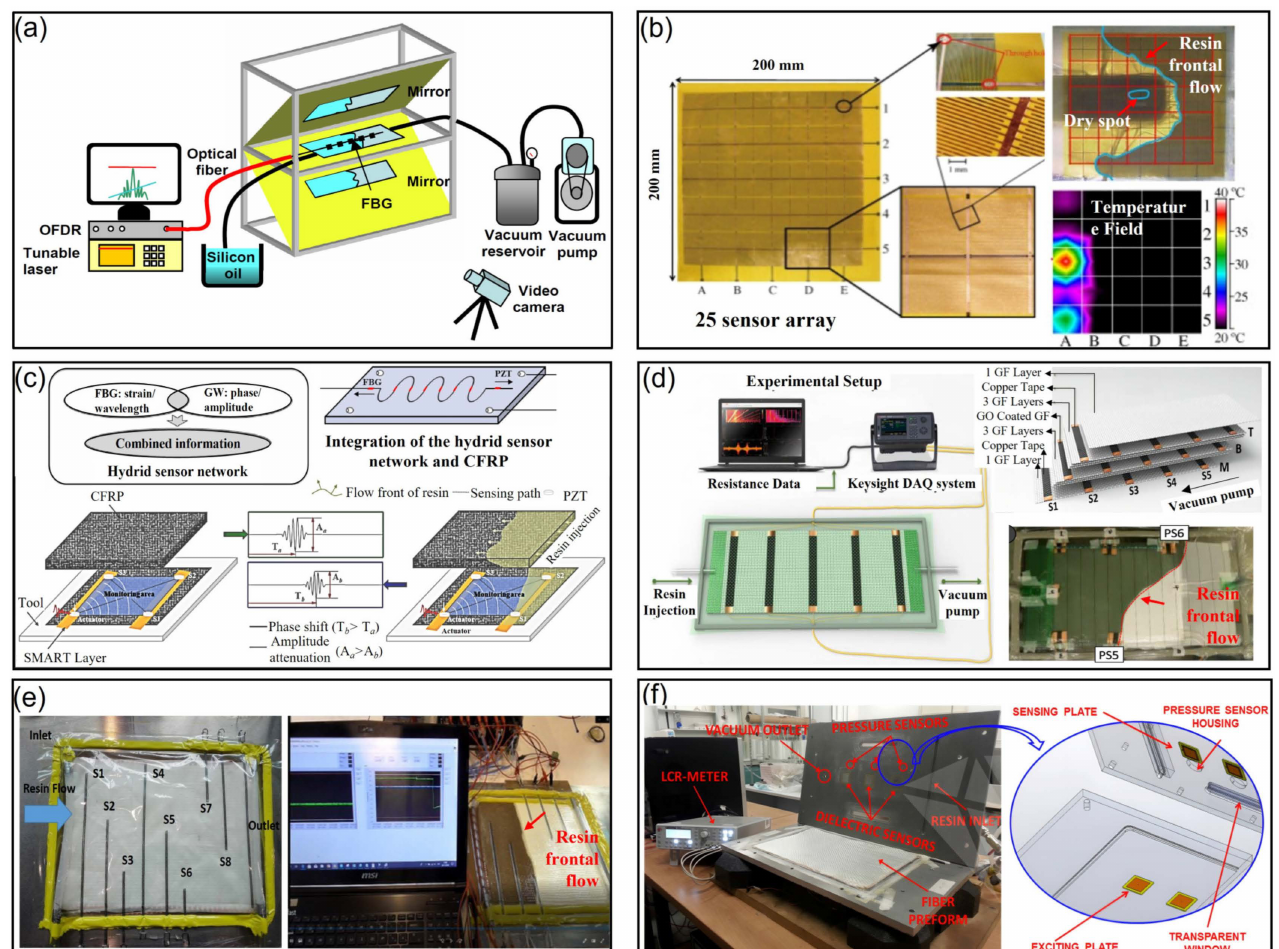
Figure 8. Monitoring systems for resin flow based on ( a ) FBG sensor (Reprinted with the permission from Ref. [105]. 2007, Photo-Optical Instrumentation Engineers (SPIE), ( b ) interdigital electrode array film (Reprinted with permission from Ref. [108]. 2011, Elsevier), ( c ) hybrid FBG/piezoelectric sensor network (Reprinted with permission from Ref. [111]. 2022, Elsevier), ( d ) graphene-coated glass fabric sensors (Reprinted with permission from Ref. [109]. 2022, John Wiley and Sons), ( e ) electrically resistive sensors made of reinforced continuous carbon fibers (Reprinted with permission from Ref. [112]. 2021, Elsevier), and ( f ) non-invasive dielectric monitoring sensors [113]. 2018, Springer